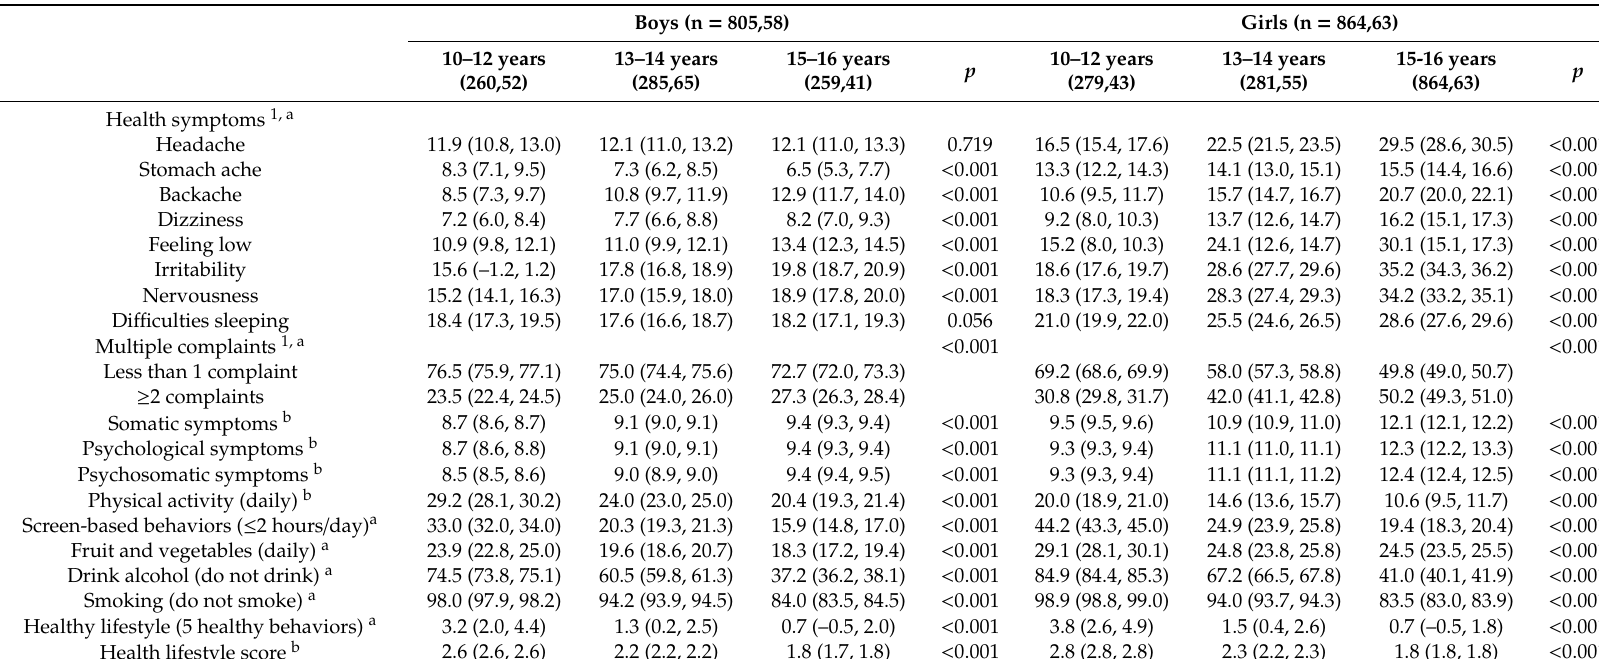
Table 2. Relationship between subjective health complaints, healthy behaviors, and healthy lifestyle computed variable and adolescents age